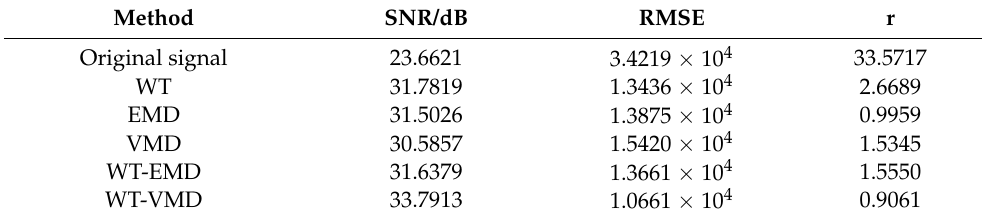
Table 3. Evaluation index of 1000-pulse cumulative signal (no pollution) after